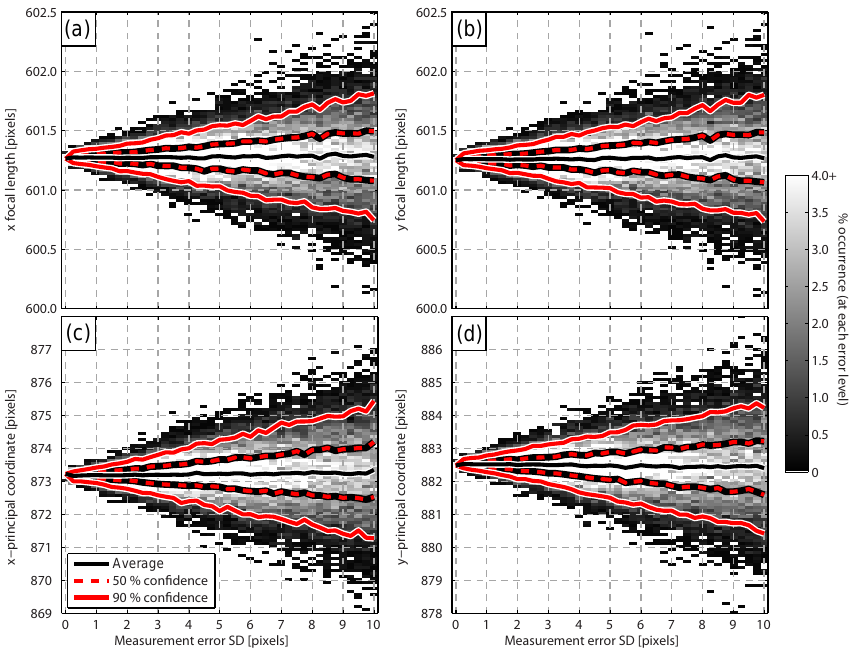
Figure 5. Distributions of (a) x focal length α x ; (b) y focal length α y ; and (c) , (d) principal point (x o ,y o ) are shown as a function of measurement error standard deviation σ j . The mean, 50 and 90% confidence intervals are shown as